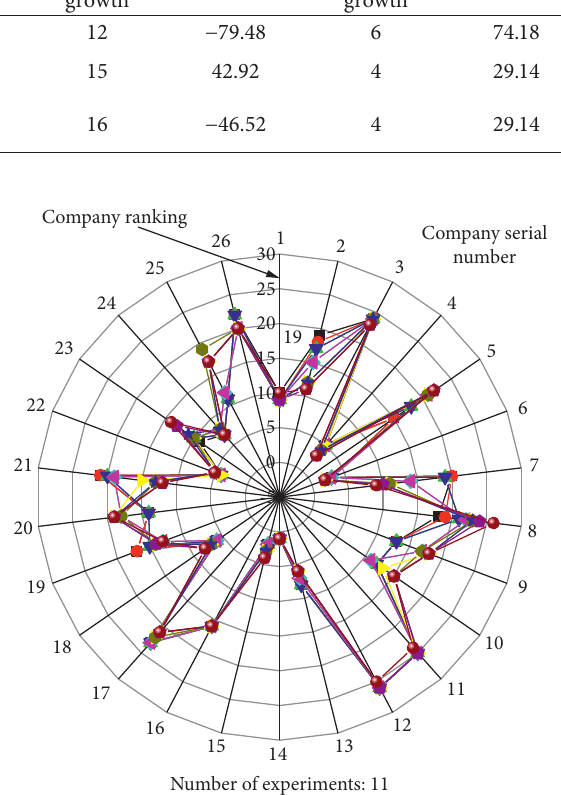
Figure 1: Improved VIKOR method parameter V sensitivity analysis results.